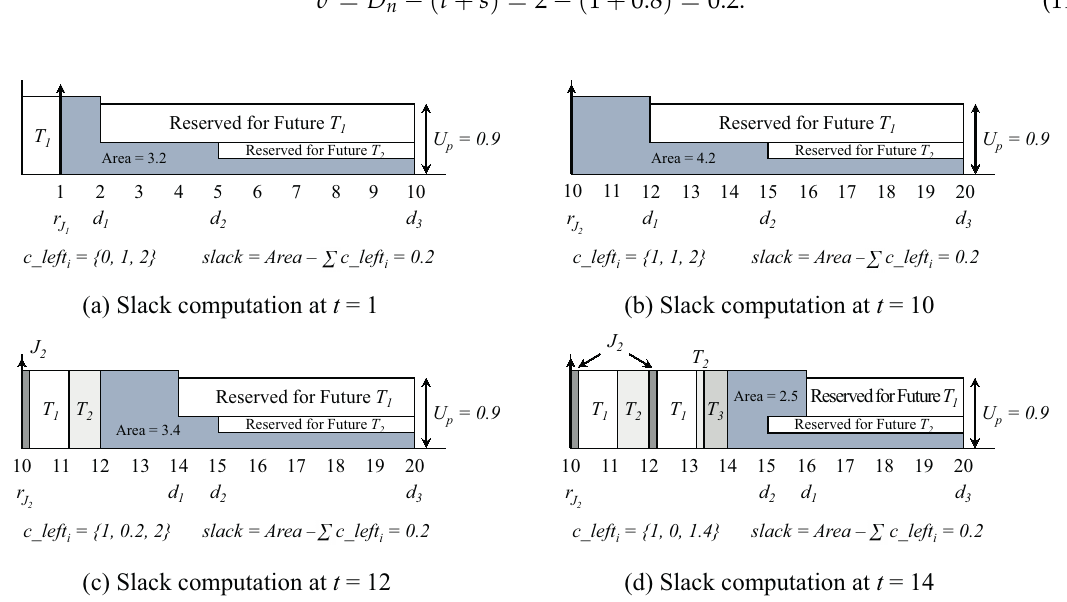
Figure 3. Slack computation examples: ( a ) shows the slack computation result of at t = 1. Excluding the amount of work in the future release periodic tasks, the available processor is 3.2, which is the shaded area, and the sum of the amount of work in the periodic task is 3, so there is a slack of 0.2. Panel ( b ) shows the slack computation result of at t = 10. Panel ( c ) shows the slack computation result of at t = 12. Panel ( d ) shows the slack computation result of at t =